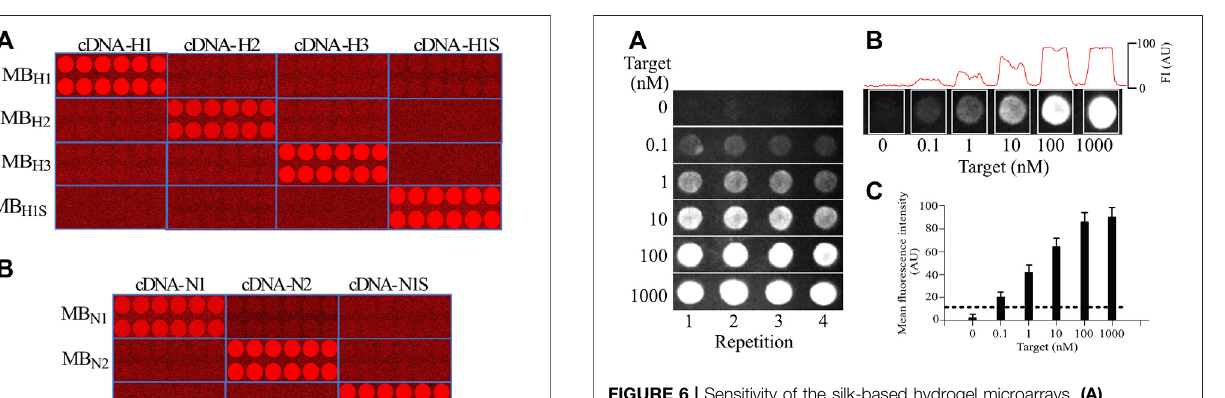
FIGURE 6 | Sensitivity of the silk-based hydrogel microarrays. (A) , testingdifferentconcentrationsofthetargettoexplorethesensitivityoftheMB (0.1, 1, 10, 100, 1,000 nM). Each microarray row (replica) is independent. All concentrations were tested on independent microarrays (not subsequently added). (B) , measuring the fl uorescence on each microarray spot to obtain the mean value, which was used to determine the sensitivity limit. All concentrations were tested on independent microarrays (separated by the white boxes). (C) , the sensitivity limit obtained from the measurements as shown in B. Each bar shows the mean ± standard deviation from at least 5 spots in the same microarray and from 6 independent microarray replicas. The dotted line shows the threshold for noise, determined as 3 standard deviations from the background signal. Above, this dotted line signal is considered different from background noise (illustrated in the 0-target concentration in A and